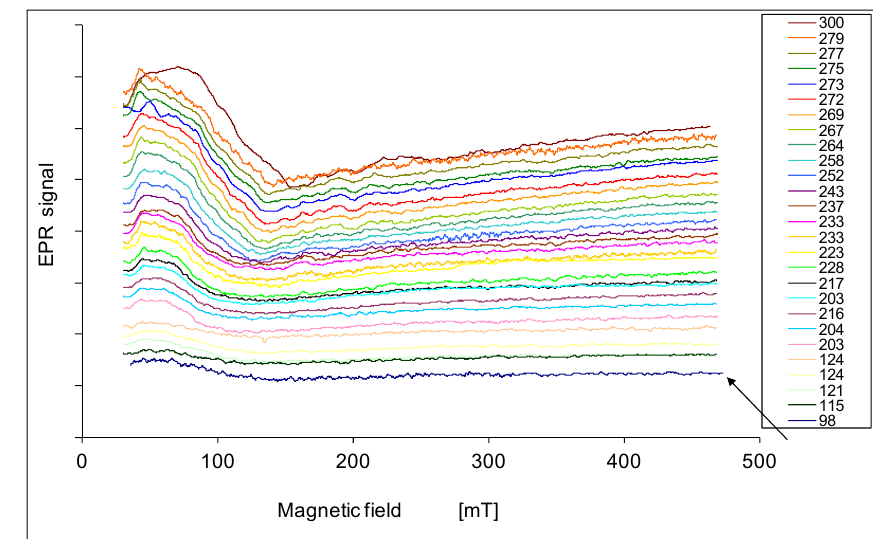
Figure 2. EPR spectra of the sample 2p at various temperatures in K.